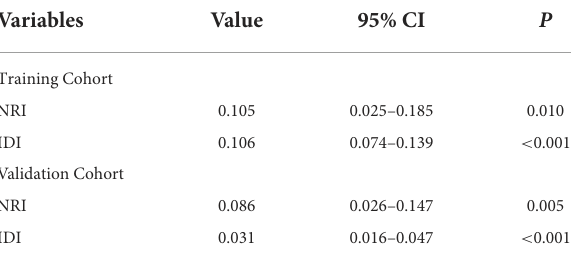
TABLE 4 Comparison of the prediction ability between Model 1 and Model 2 through NRI and IDI.